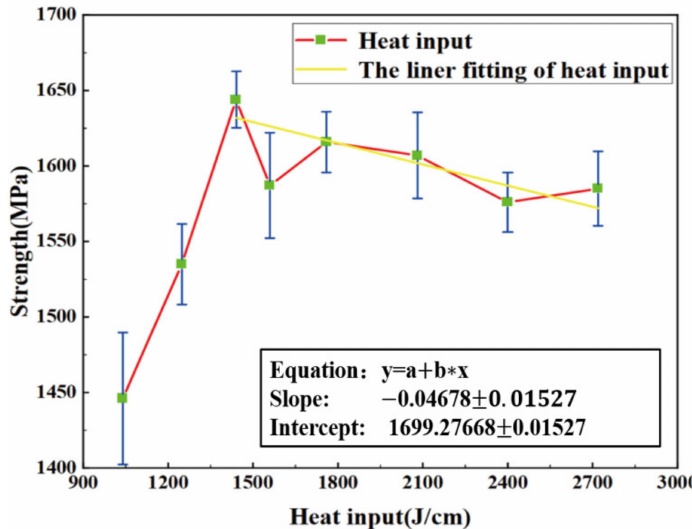
Figure 5. The tensile strength of all the samples at different heat inputs after quenching.